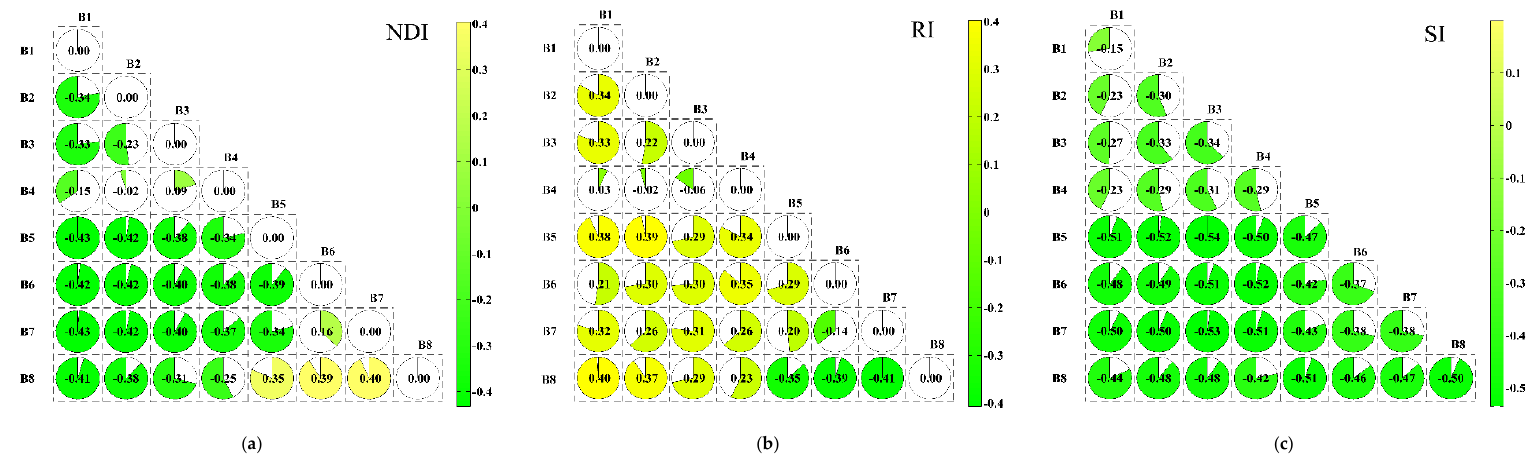
Figure 6. The correlation analysis between EC and optimized spectral indices based on first derivative (R-FD). ( a – c ) represent the correlation EC with NDI, RI, and SI,